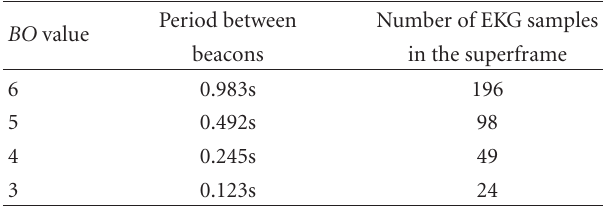
Table 2: Tradeo ff between packetization delay and number of samples carried in each superframe.